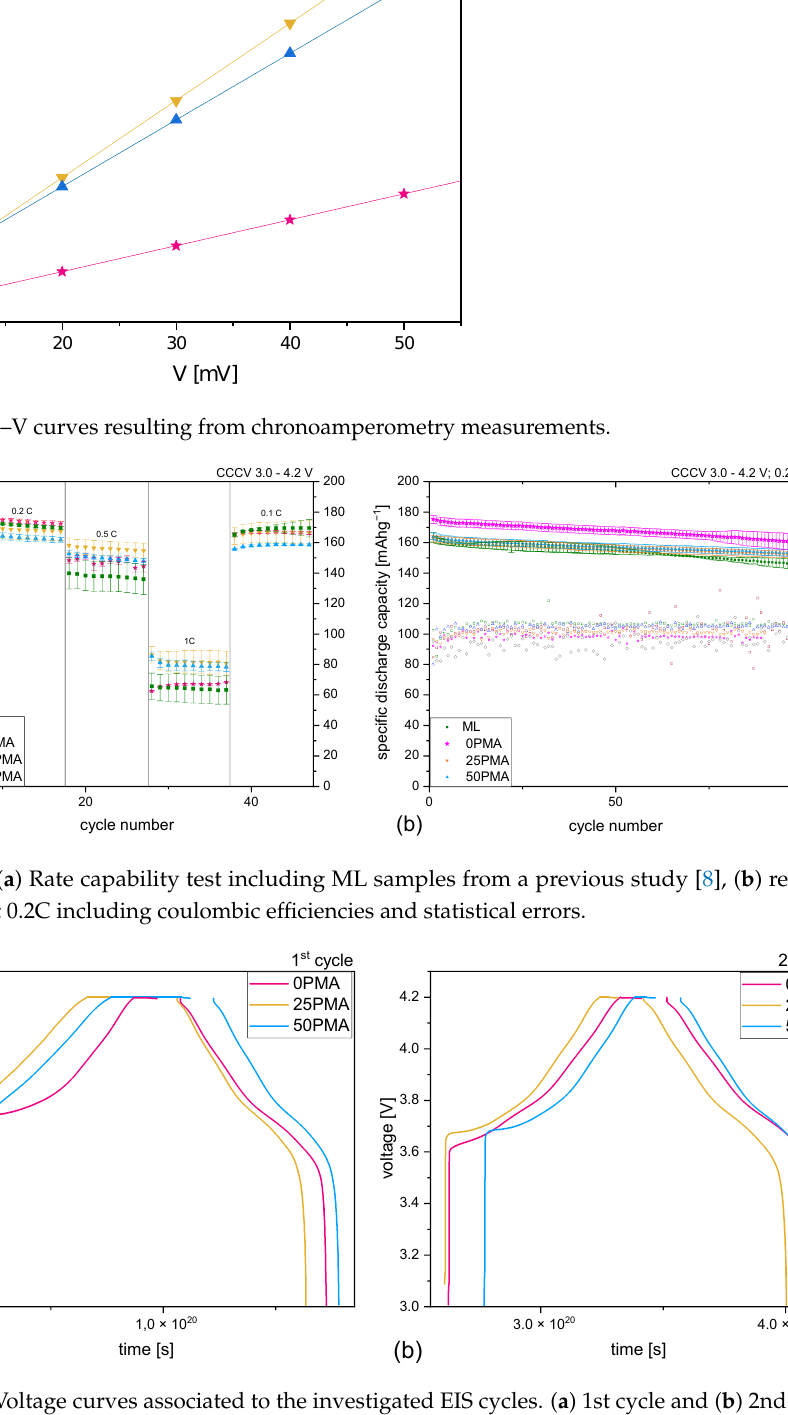
Figure A6. Voltage curves associated to the investigated EIS cycles. ( a ) 1st cycle and ( b ) 2nd